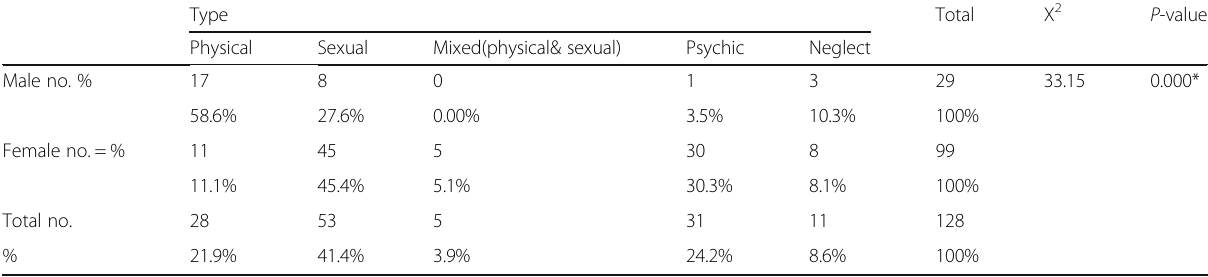
Table 4 Relation between gender and type of violence among the studied cases